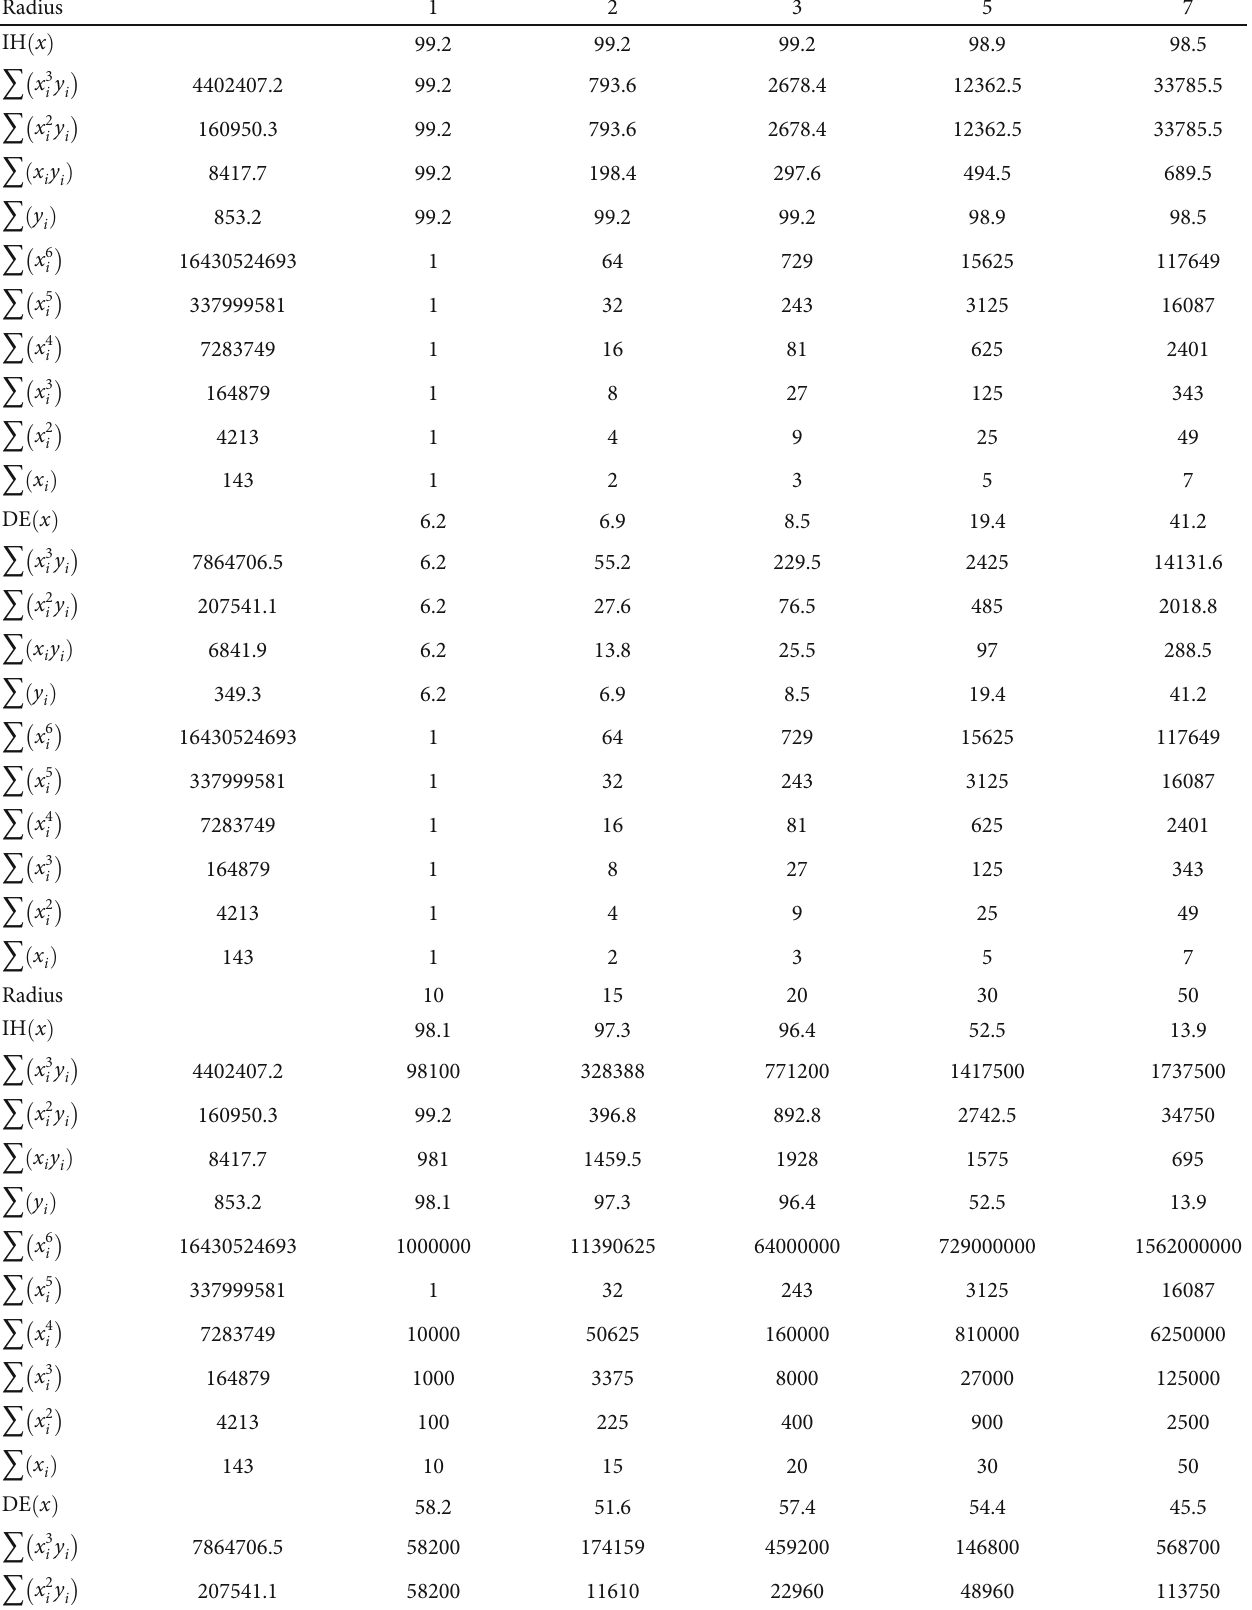
Table 4: Calculation process of IH ð x Þ and DE ð x Þ